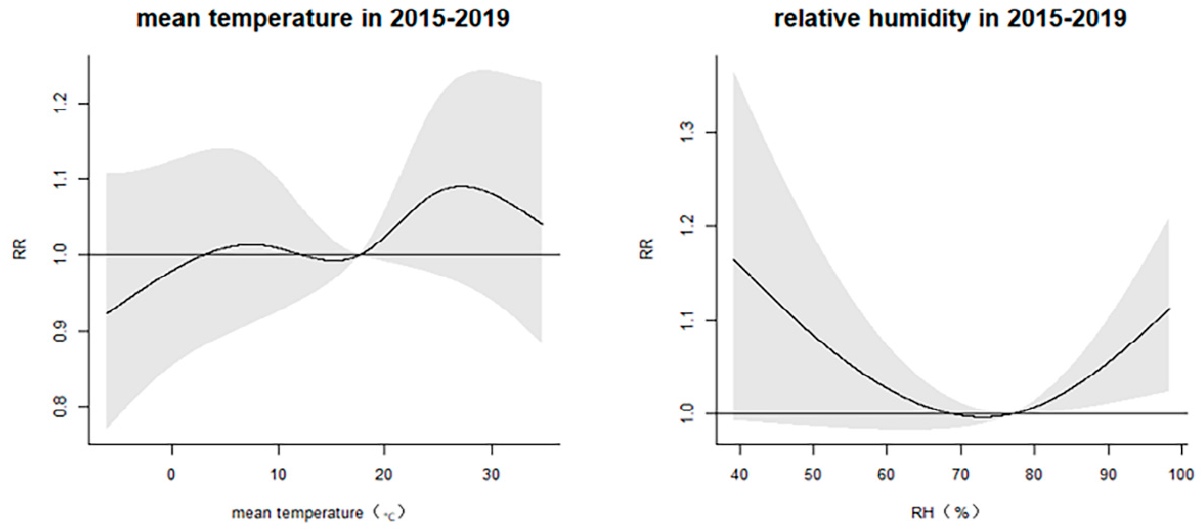
Figure 2. The overall exposure–response association curve between mean temperature and relative humidity and daily outpatient visits for HZ.